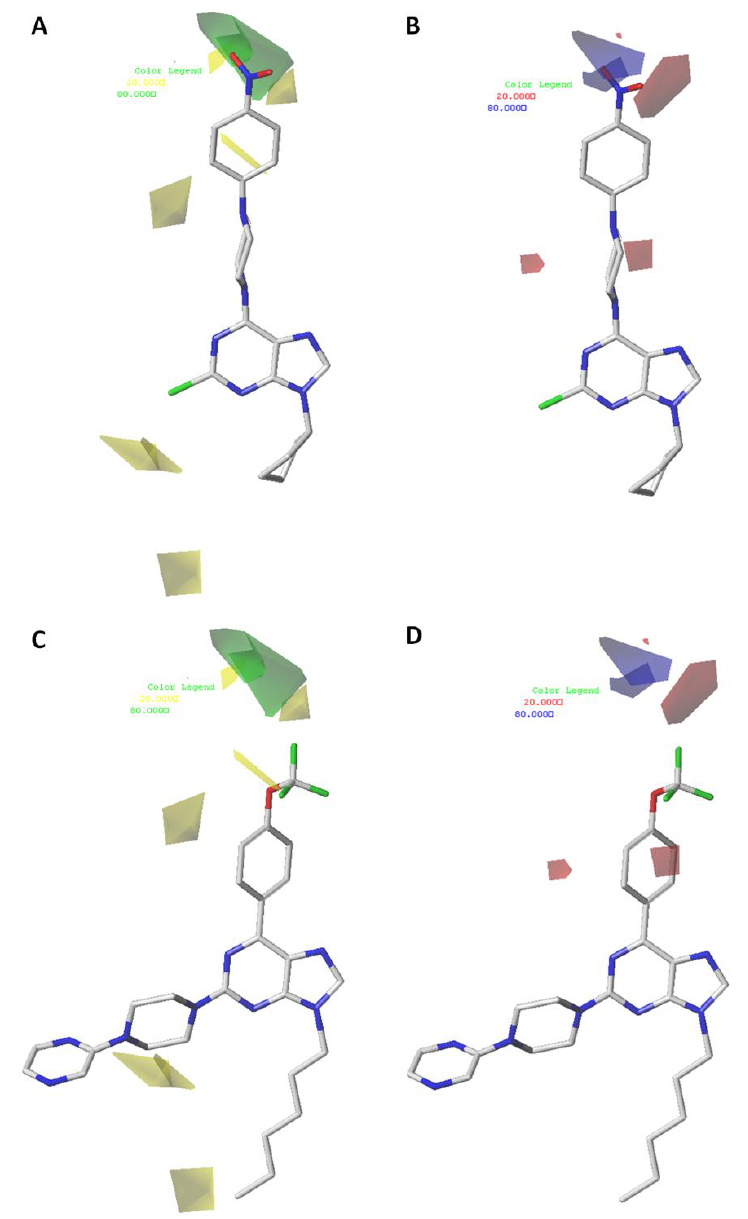
Figure 5. CoMFA NCI-H460: Steric ( A , C ) and electrostatic ( B , D ) contour maps around the most active compound of the series, 7h ( A , B ), and the least active compound of the series, 4s ( C , D ).